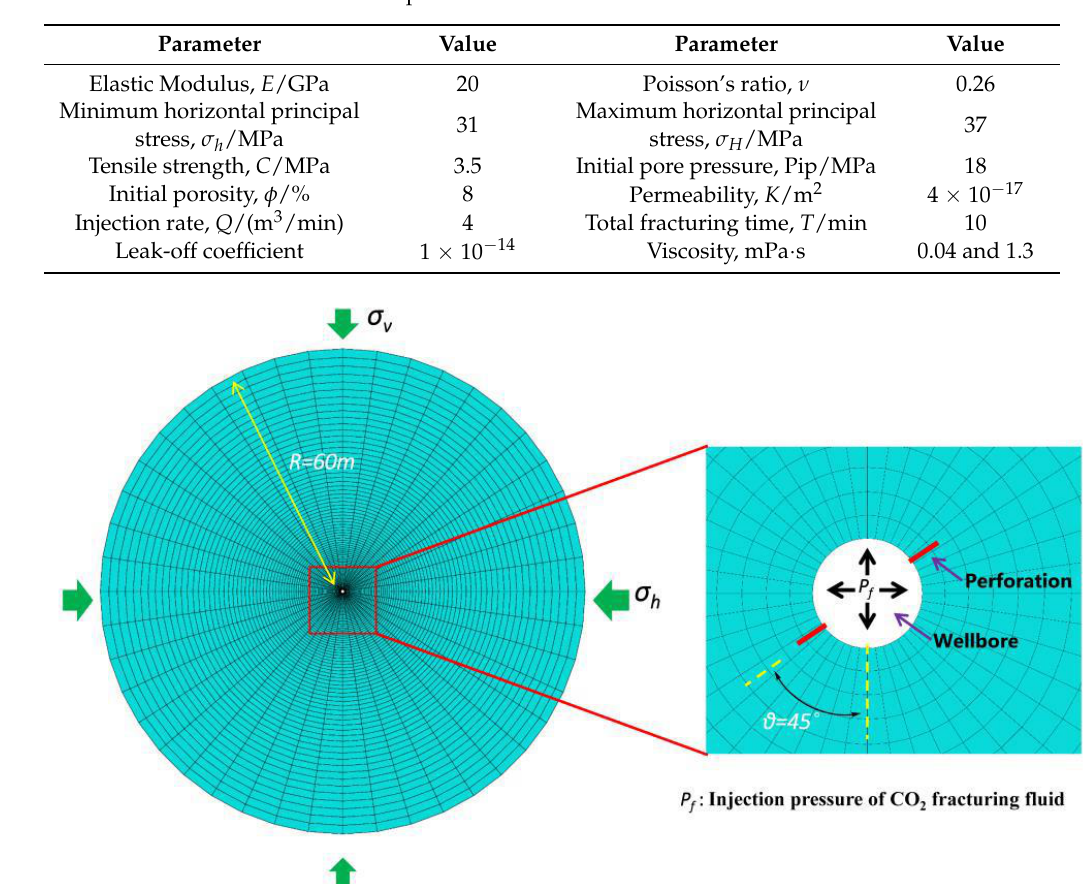
Table 1. The characteristic parameters and the initial conditions of shale reservoirs.